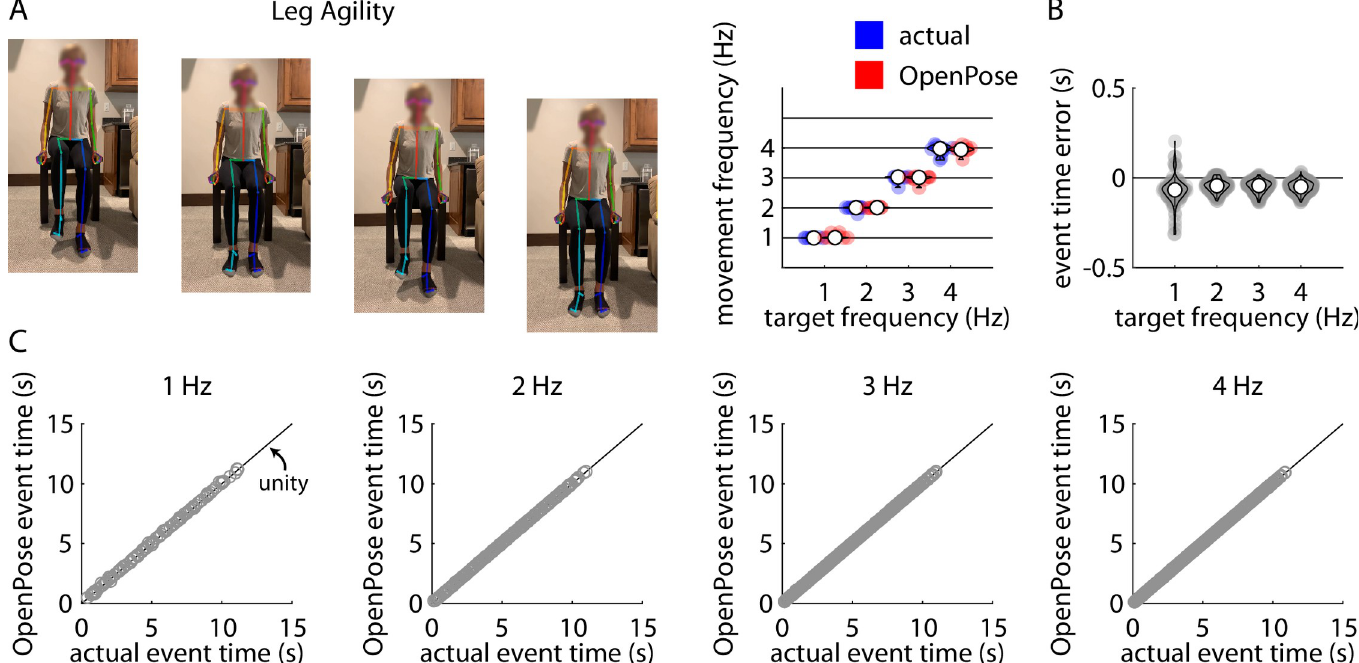
Fig 6. A) Representative example of stillframes from an OpenPose output video of a participant performing the leg agility (i.e., heel tapping) task (left) and violin plots showing comparisons of individual participant mean heel tapping frequencies measured manually (“actual”, blue) and using our pose estimation workflow (“OpenPose”, red) across all four target frequencies (right). B) Violin plots showing event time errors (i.e., differences between video timestamps of heel taps as measured manually and using pose estimation) for each individual heel tap across all participants. C) Scatter plots showing relationships between the video timestamps of all individual heel taps across all participants as measured manually (x-axis) or using our pose estimation workflow (y-axis) across all four target frequencies.